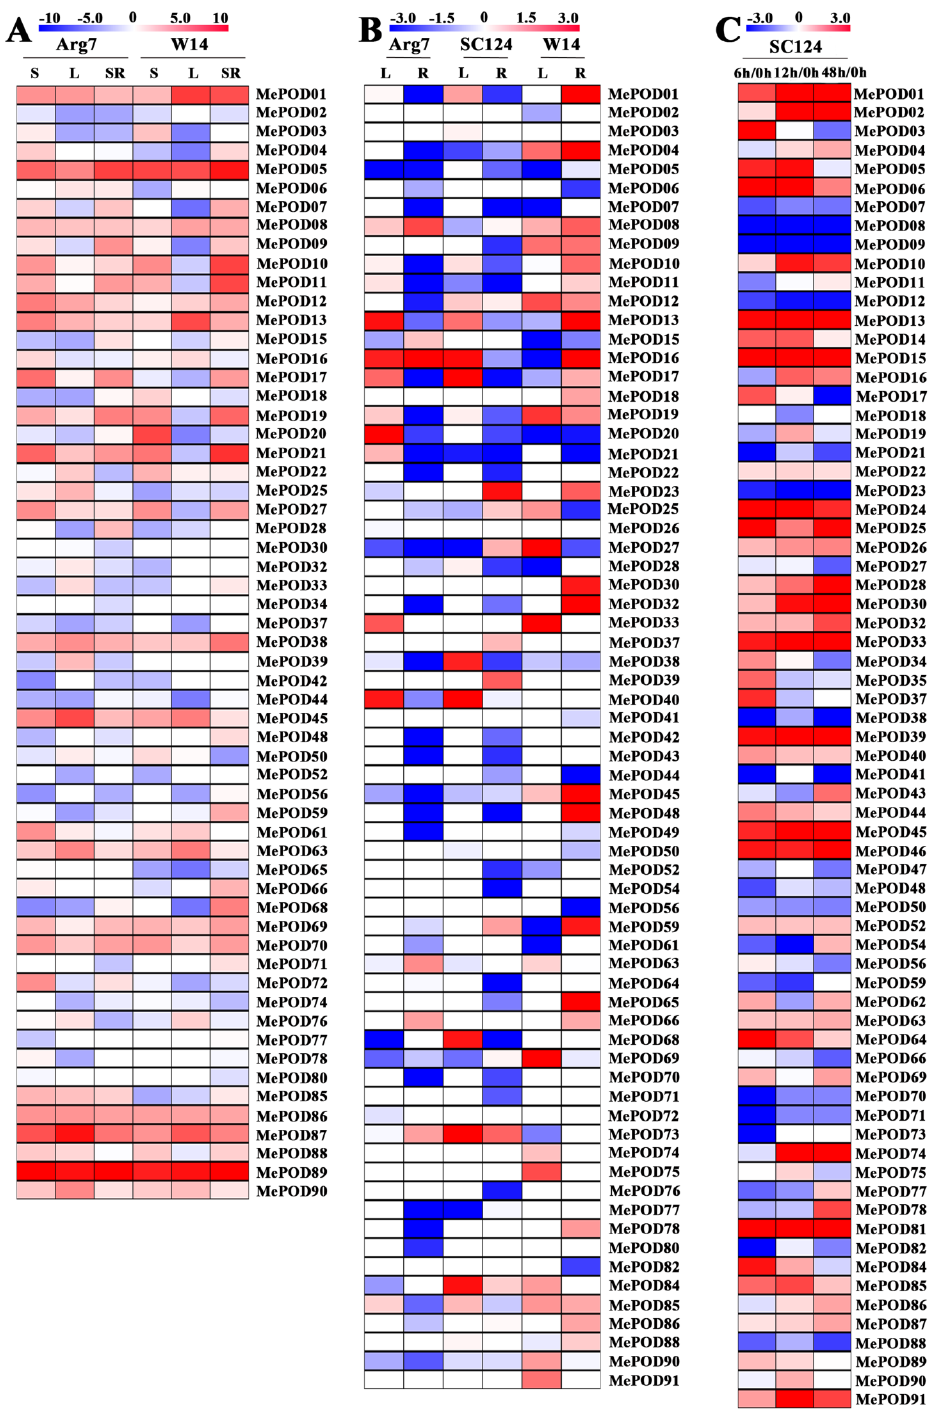
Figure 6. Transcriptomic analysis of cassava POD genes. ( A ) Expression of MePODs in the stem (S), leaf (L), and storage root (SR) of W14 and Arg7. The log2-based FPKM value was applied to build the heat map using Mev4.9.0 software (CCCB, Boston, USA). ( B ) Expression of MePODs in the leaf (L) and root (R) of Arg7, SC124, and W14 after drought treatment relative to under normal conditions. Log2-based fold changes (L / control; R / control) were applied to build the heat map using Mev4.9.0 software. ( C ) Expression of MePODs in the storage root at 6, 12, and 48 h relative to 0 h after harvest. Log2-based fold changes were applied to build the heat map using Mev4.9.0